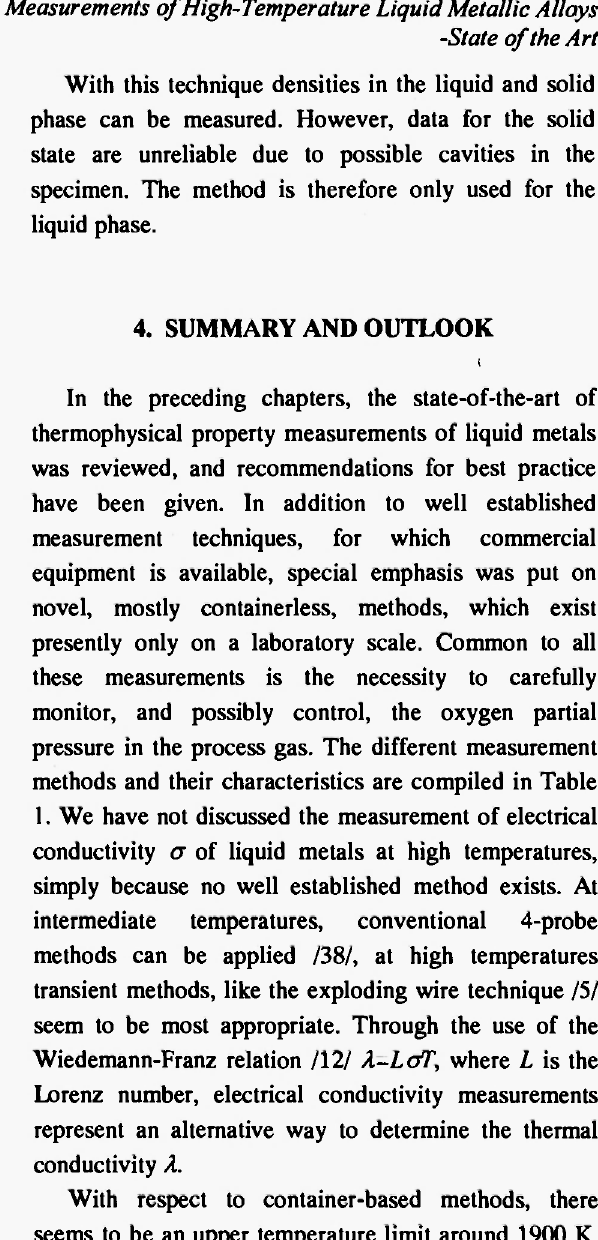
Fig. 19: Diagram of a levitated drop density apparatus - NPL setup.